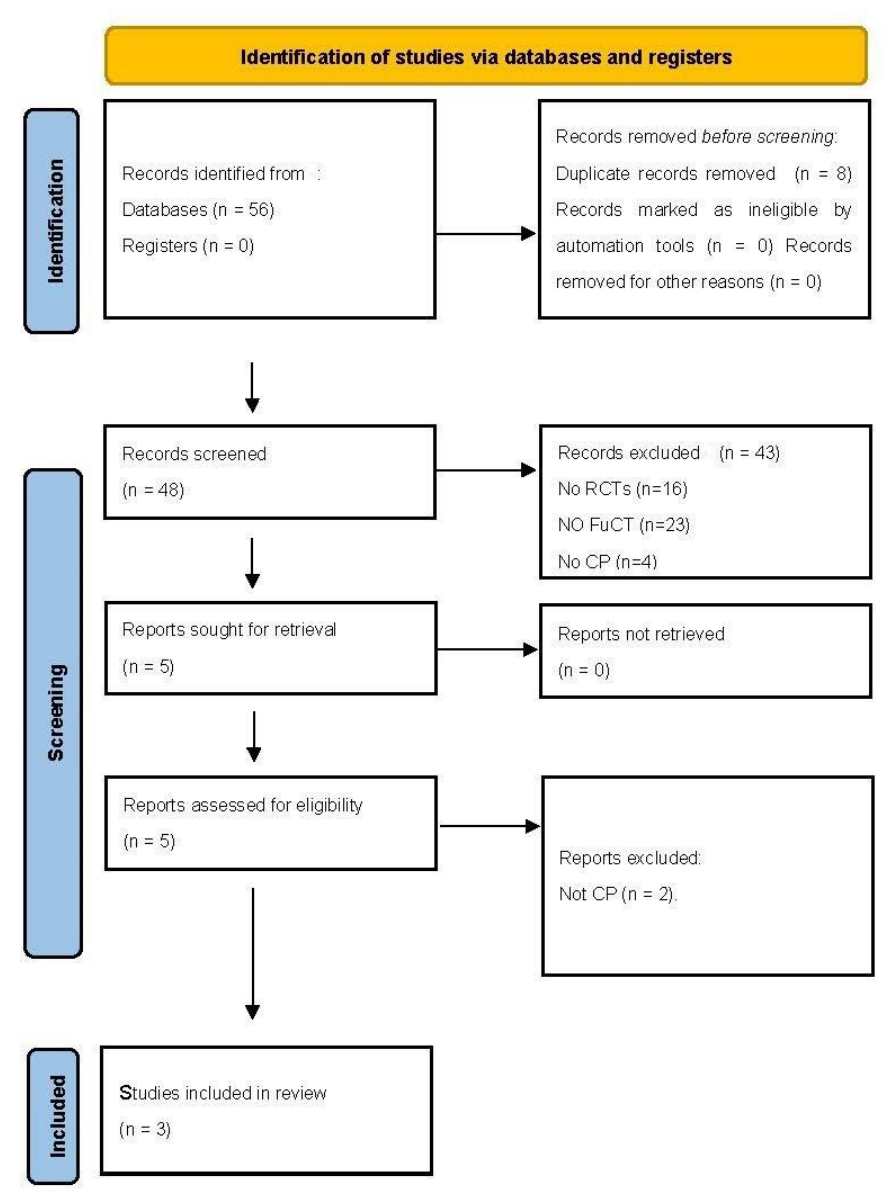
Figure 1. Articles selected from the databases.